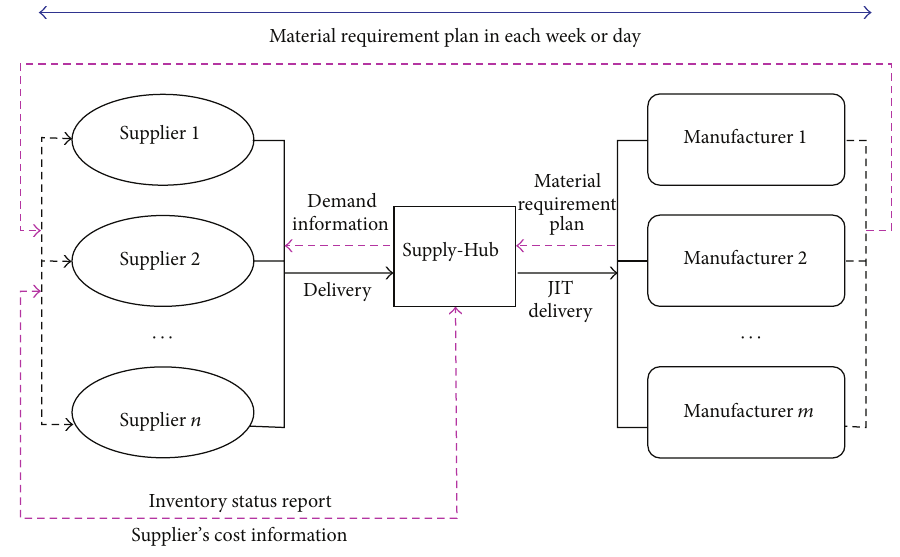
Figure 1: Multi-suppliers and multi-manufacturers operation mode based on the